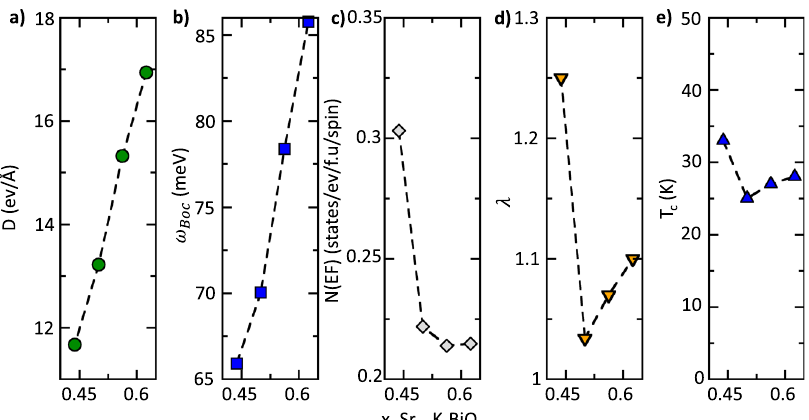
Fig. 7 Superconducting properties as a function of the doping content x in Sr 1-x K x BiO 3 . a Reduced electron-phonon matrix element (D, in eV/Å), b breathing mode frequency ω Boc (in meV), c density of states N(E F ) at the Fermi level, d computed electron-phonon coupling constant, and e estimated critical temperature T c (in K) for a screened Coulomb potential µ* = 0.15 as a function of the doping content